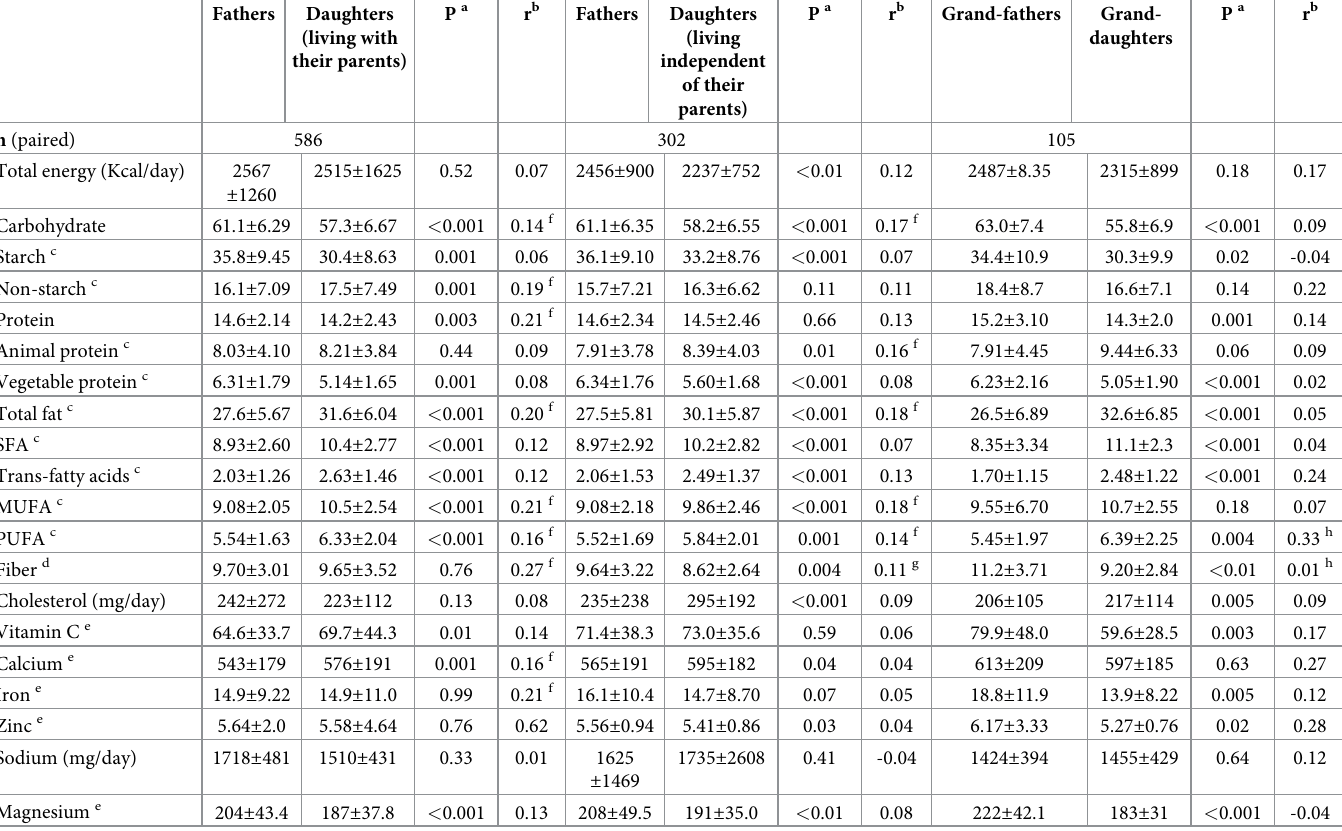
a Paired t-test for the difference of energy and dietary intakes b Partial correlation (adjusted for age, physical activity and body mass index).